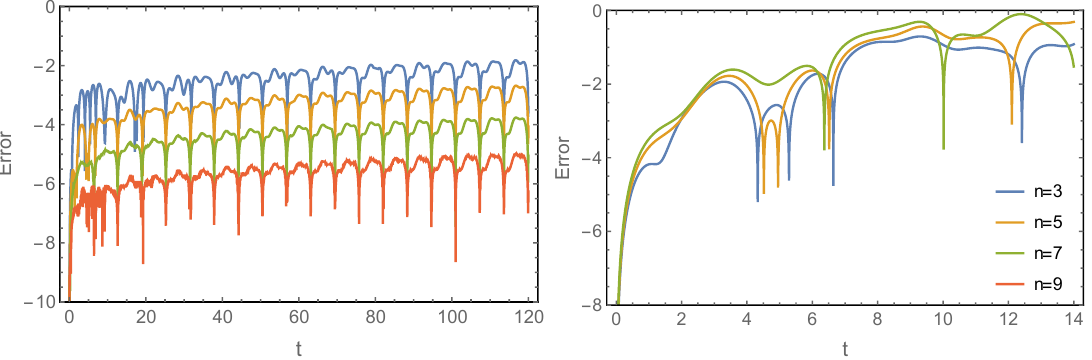
Figure 8. Error (in logarithmic scale) in the transition probability committed by FM (left) and LD (right) with n = 3,5,7,9 terms each for the Bloch-Siegert Hamiltonian with ε = 0.5. Notice the different time interval in each